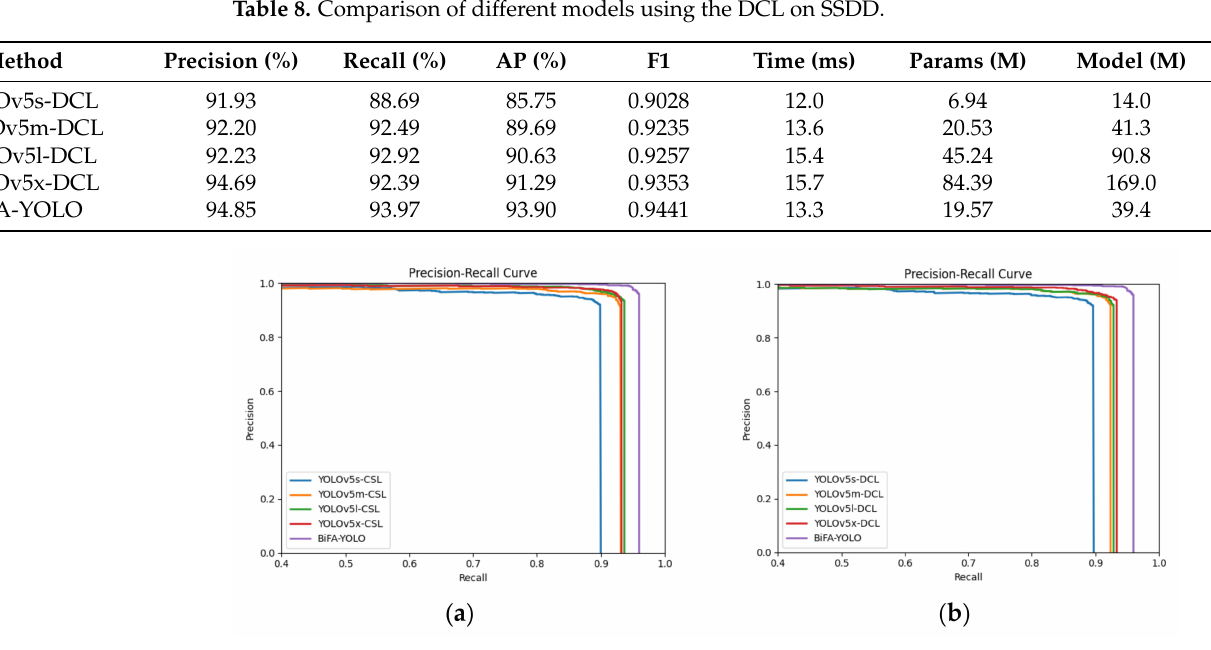
Figure 11. Precision-Recall (PR) curves of different models on SSDD. ( a ) PR curves of